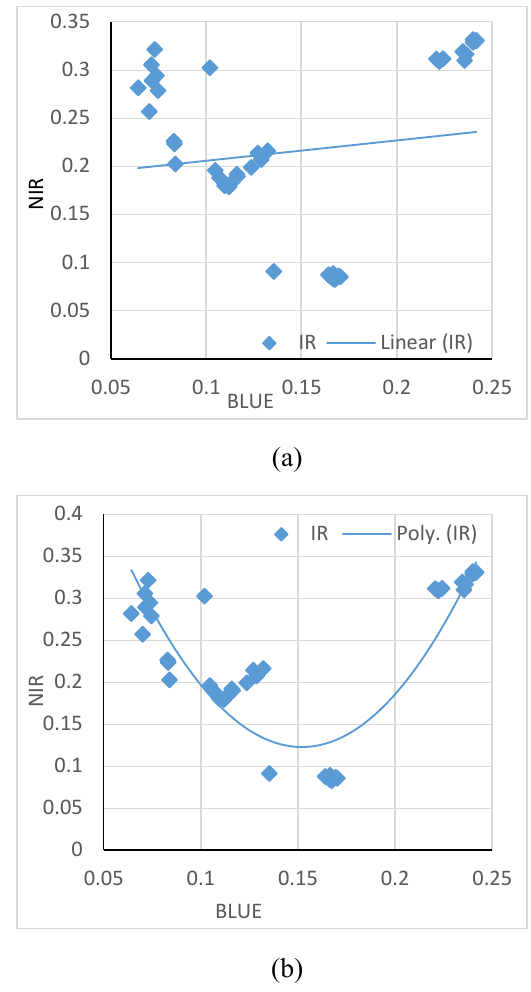
Figure 2: Scatterplot (NIR vs. Blue) (a) Linear fitting (b) Polynomial